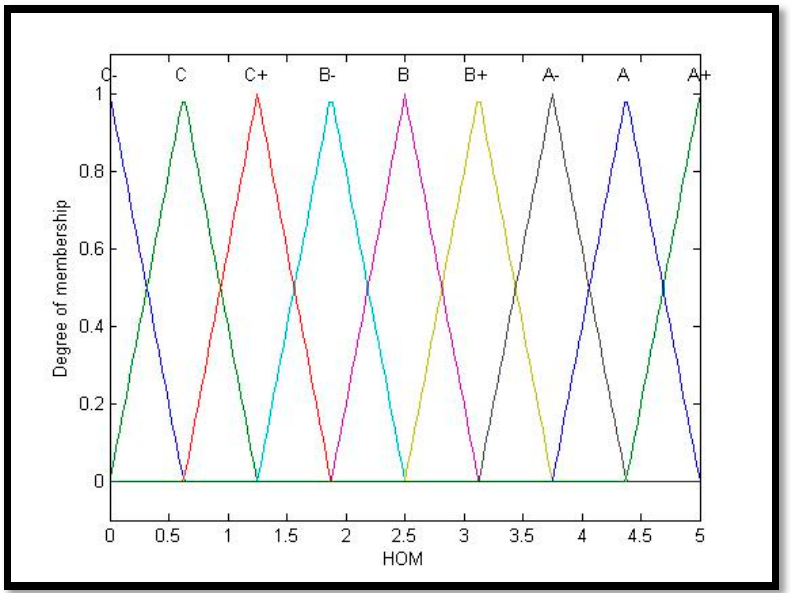
Figure 8. Membership function of linguistic HOM.